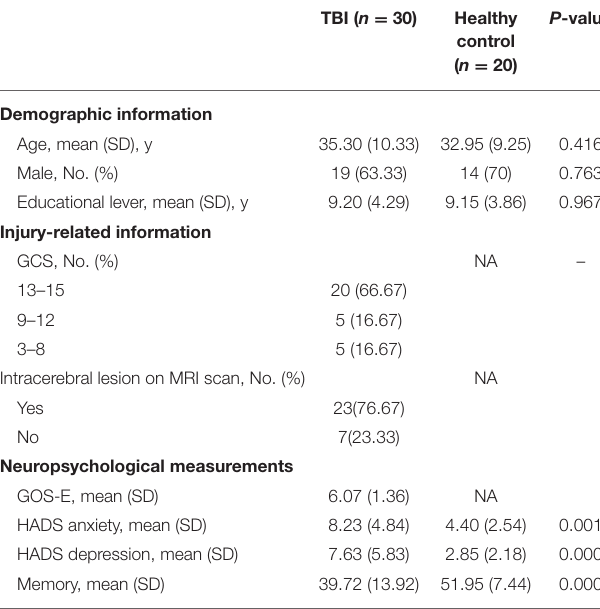
TABLE 1 | Demographics and clinical characteristics in patients with traumatic brain injury (TBI) and healthy